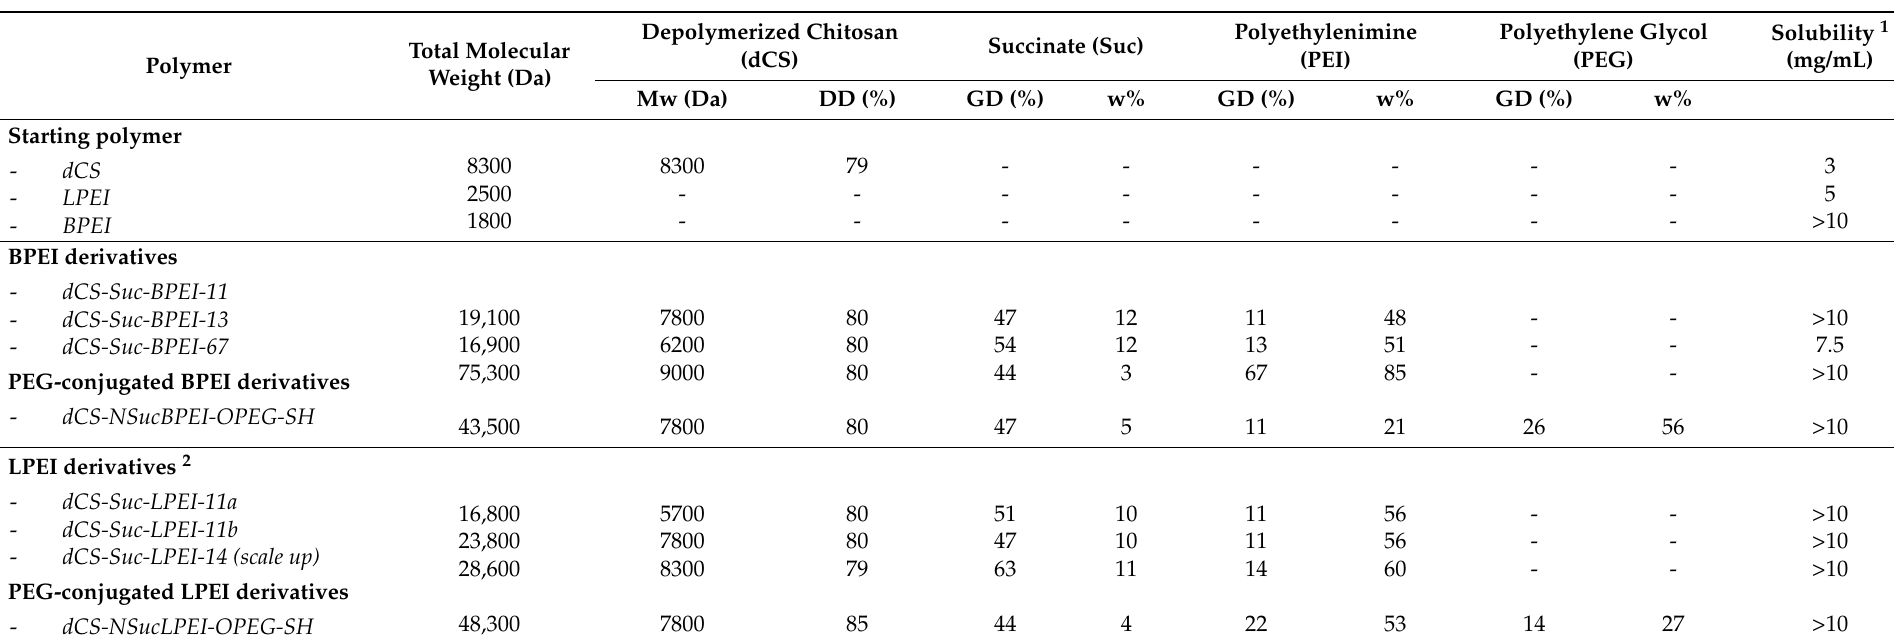
Table 1. Physicochemical properties of selected dCS-PEI derivatives and their precursors. Characteristics of the dCS backbone used, grafting degree of the succinyl linker or the polymer on dCS, and water solubility are displayed for each copolymer. Grafting degrees (GD) (%) of LPEI and BPEI are indicated at the end of the name of each functionalized polymer. Molecular weights of the dCS backbones were estimated by gel permeation chromatography (GPC) and GD were determined by 1 H NMR. Nomenclature: cf. Figure